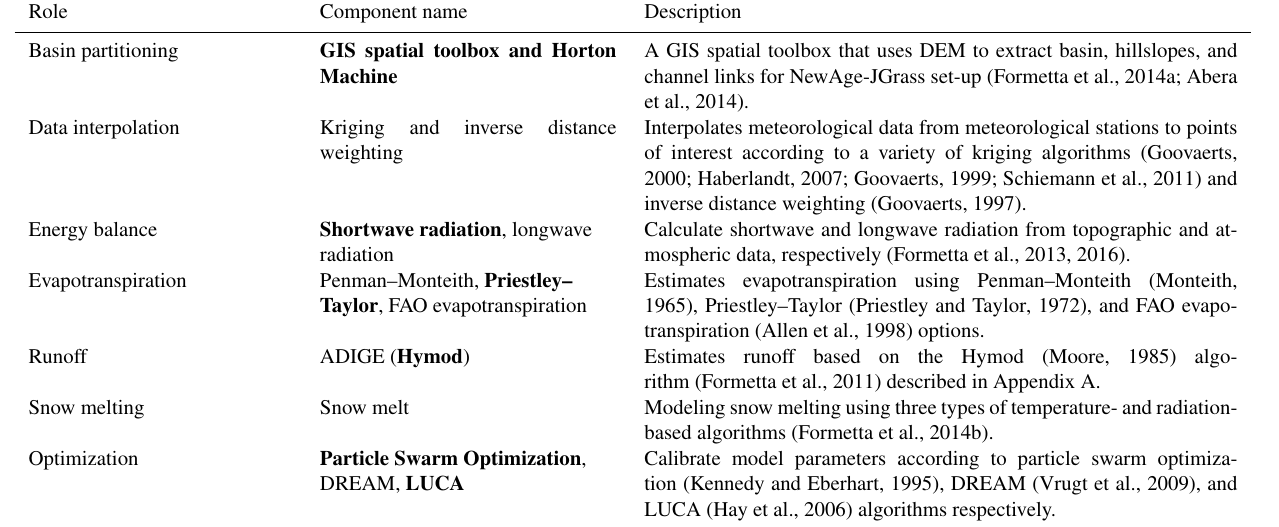
Table 1. JGrass-NewAge system components and respective references. The components in bold are the ones used in this study.